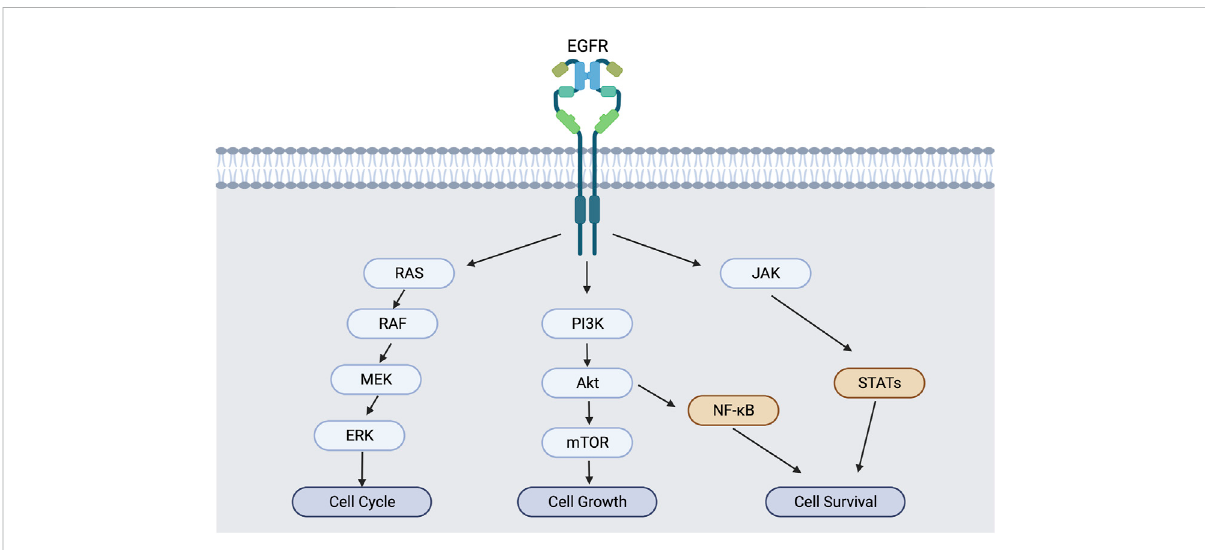
FIGURE 2 EGFRactivationanddownstreamsignalingcascade.EGFRactivationinducesnotonlyMAPK/PI3Kpathways,butalsoNF- κ BandSTATpathways for cell survival and in fl